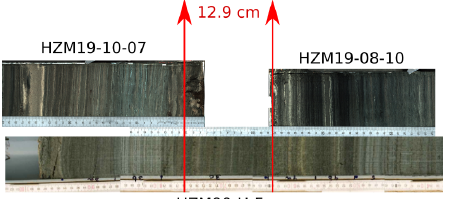
Figure A1. Determination of the technical gap for HZM19 dur- ing the YD. This gap exists between sections HZM19-10-07 and HZM19-08-10 and is bridged by section HZM90-H5u from an ear- lier coring campaign.